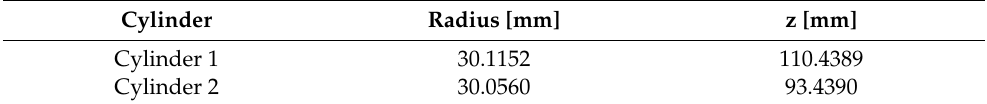
Table 2. Dimensions of the used cylinders (measured with touch probe).